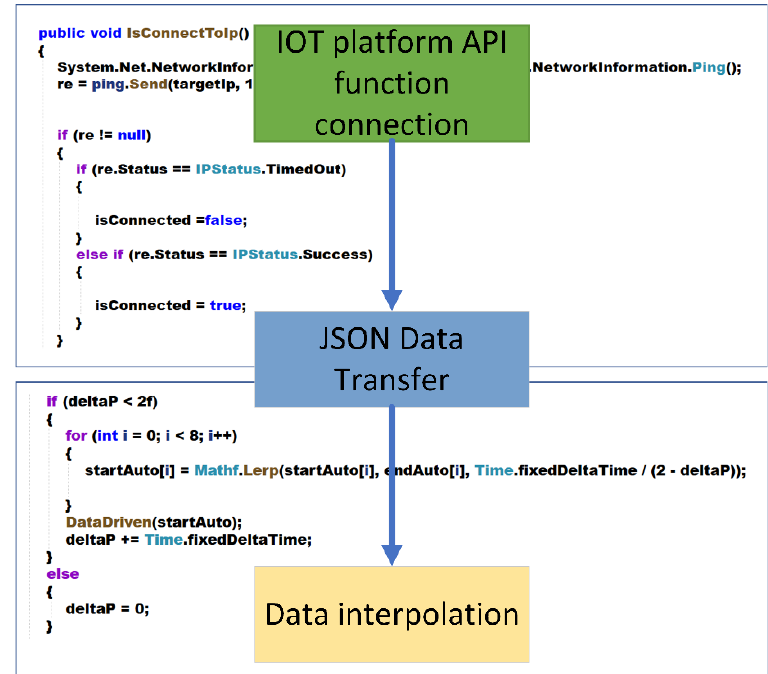
Figure 8. Data processing.